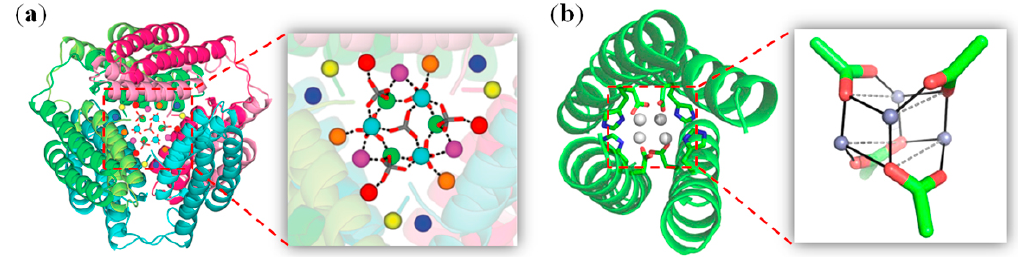
Figure 2. ( a ) Cage structure of three domain-swapped Cyt cb 562 dimers (PDB code 5AWI), and a close-up view of the Zn 2 + and SO 42 − ions in the internal cavity. Reprinted with permission from Ref. [59], Copyright 2016 The Royal Society of Chemistry; ( b ) Crystal structure of 4DH1 (PDB code 5WLL), and a close-up view of the designed tetranuclear zinc cluster. Reprinted with permission from Ref. [63], Copyright 2018 American Chemical Society.